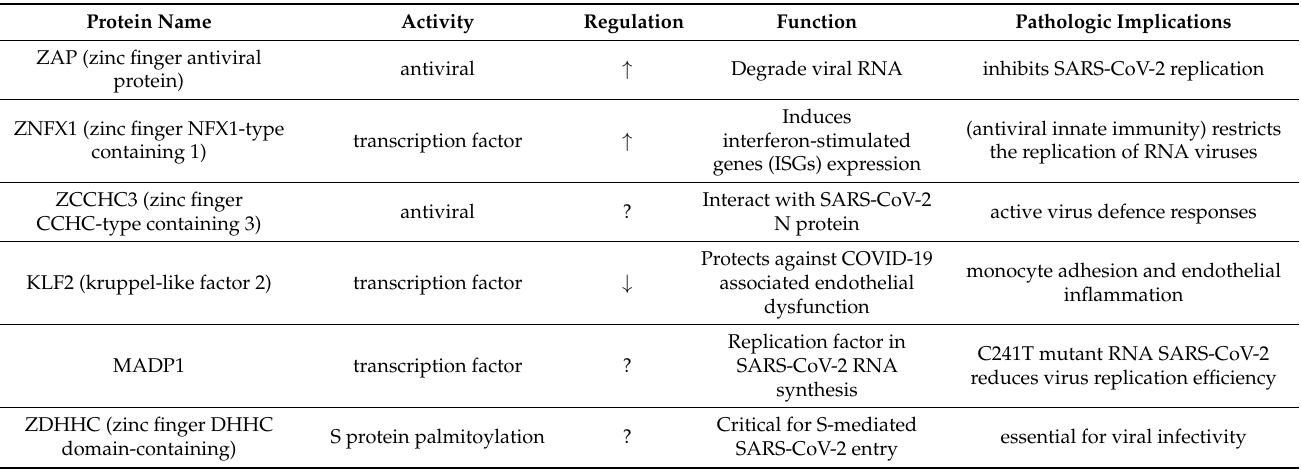
Table 1. Human zinc finger proteins in COVID-19 viral